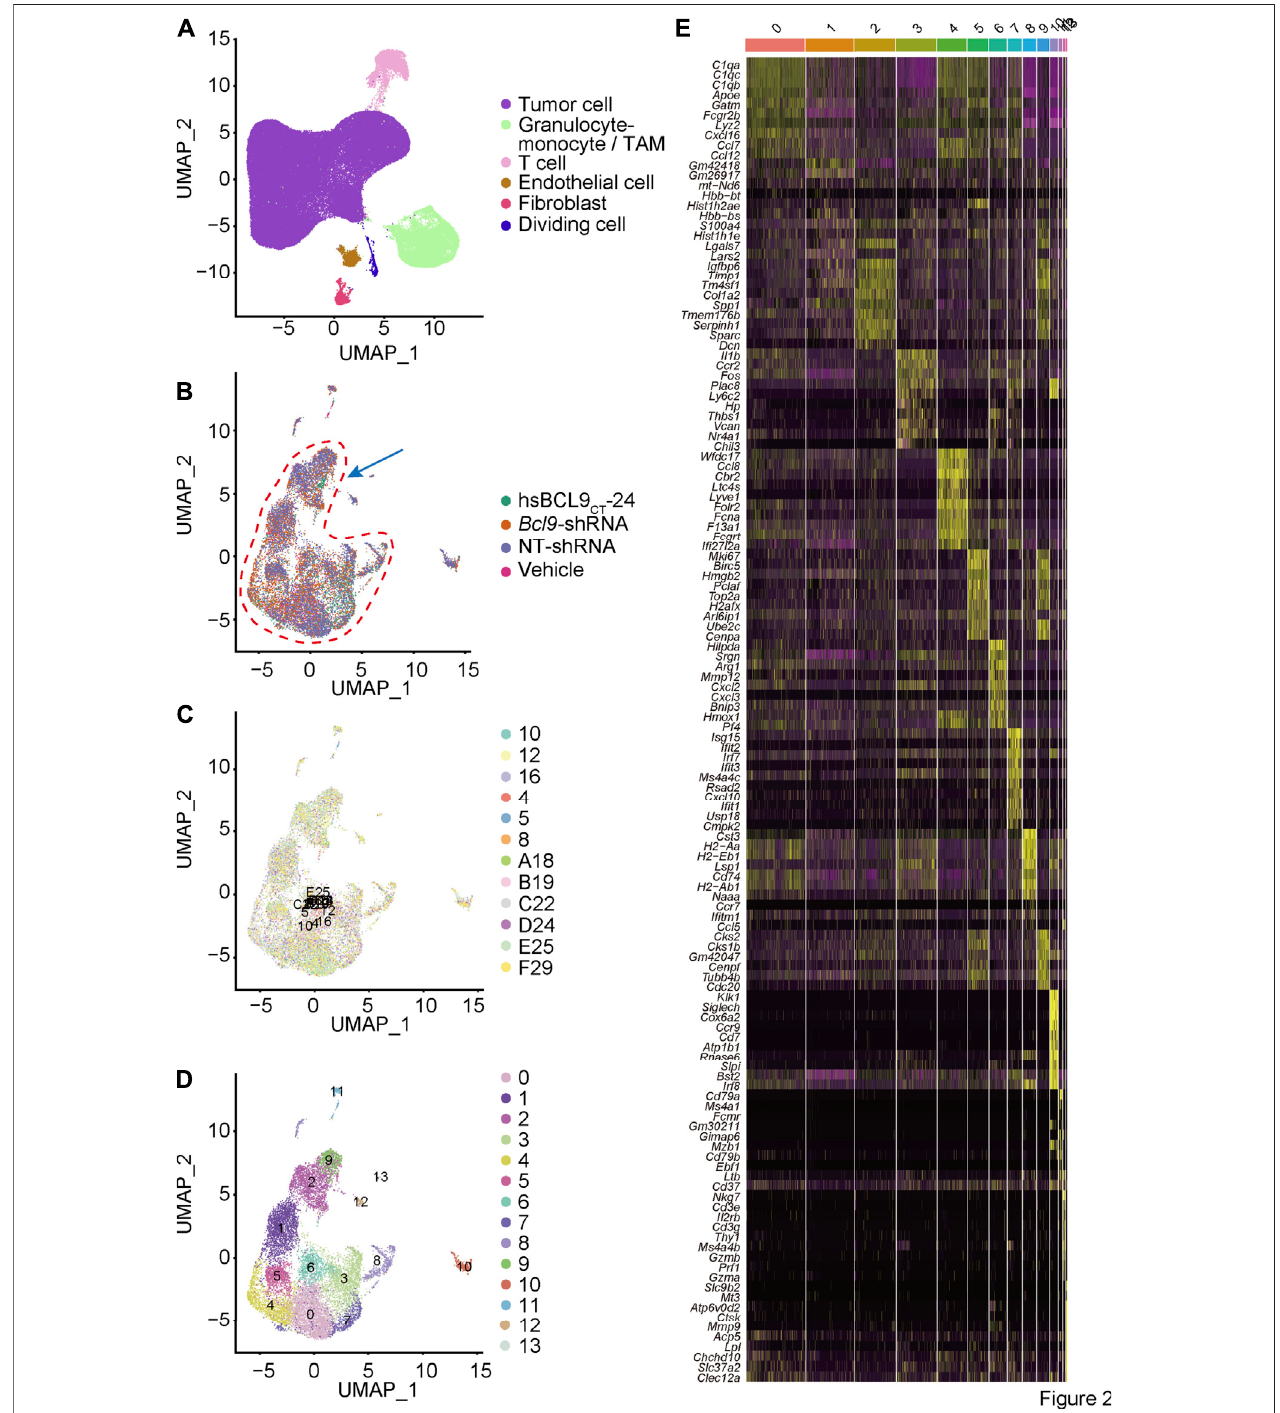
FIGURE 2 | Single cell cluster analysis of BCL9 perturbed CT26 murine tumor. (A) UMAP mapping and cell type. Re-cluster analysis of Granulocyte-monocyte (Step1re-clustering). (B) UMAPmappingandgroups(vehicle,hsBCL9 CT -24,NT-shRNA, Bcl9 -shRNA),thearrowshowsthecellpopulationswithdifference. (C) UMAP mapping and clusters. (D) UMAP mapping and three clusters (clusters 2, 9 and 12) with differences (Used for Step 2 re-clustering). (E) Heatmap of the 13 clusters from Step 1 re-clustering. Columns, individual cells; rows, genes (Top10).